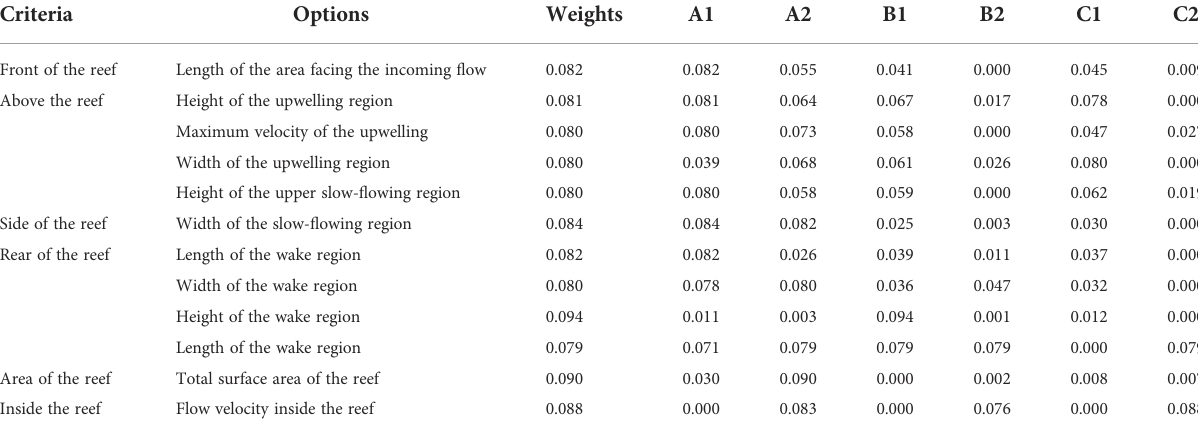
TABLE 4 Eigenvalues and weights of each fl ow- fi eld effect index of the ARs with six basic structures after normalization. Criteria